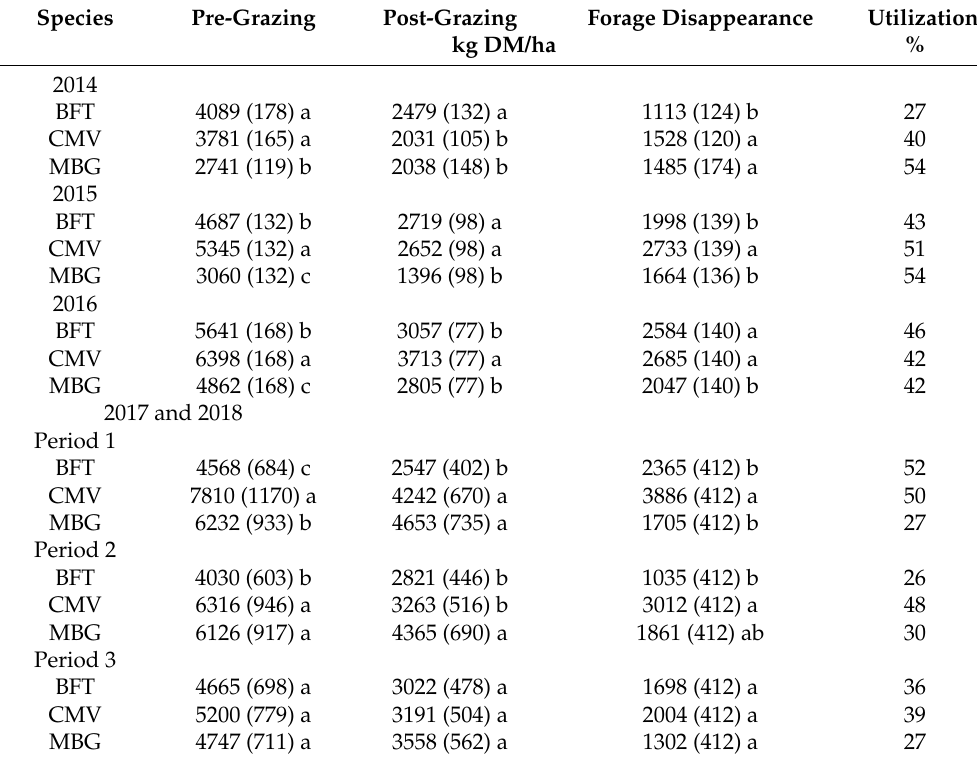
Table 3. Mean pre-grazing and post-grazing dry matter (DM), their difference, forage disappearance (SEM) and resulting pasture utilization. Species Pre-Grazing Post-Grazing Forage Disappearance Utilization kg DM/ha % 2014 BFT 4089 (178) a 2479 (132) a 1113 (124)